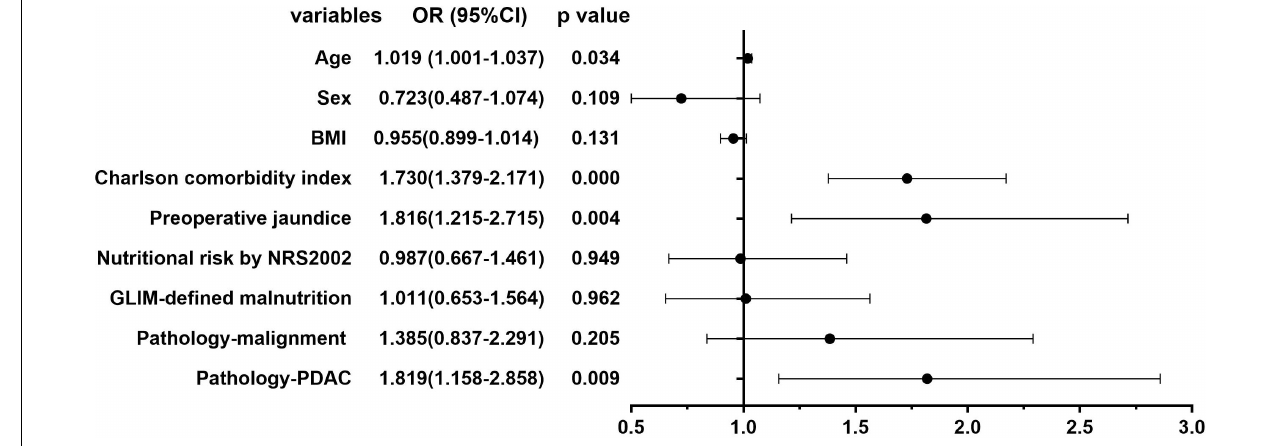
FIGURE 2 | Univariate analysis of the risk factors of preoperative anemia in all patients.